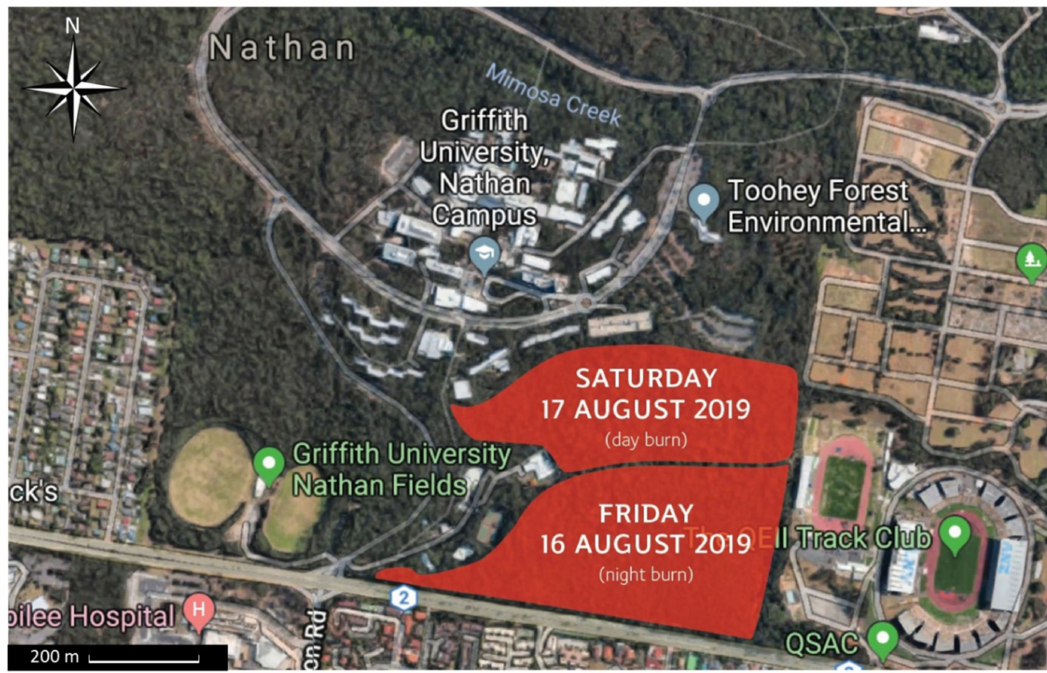
Figure 3. Map of hazard reduction burns carried out at Nathan campus of Gri ffi th University on 17 and 18 August 2019.